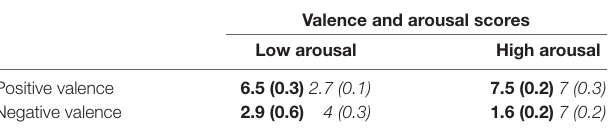
TABLE 3 | Mean valence and arousal scores for the images taken from the International Affective Picture System (IAPS) used during the passive testing